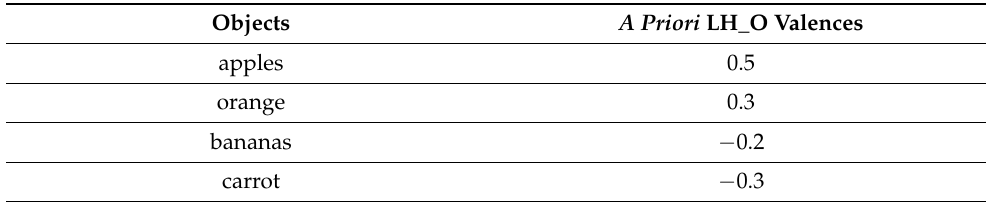
Table 5. The emotional valences of a priori LH emotion to objects in the experiments.